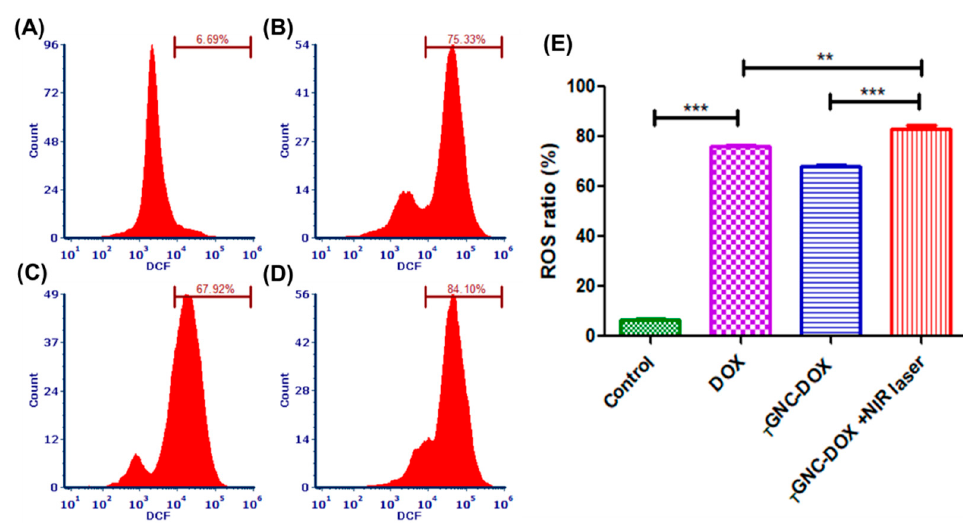
Figure 12. Intracellular ROS generation followed by treatment of: ( A ) control; ( B ) DOX; ( C ) T GNC-DOX only; ( D ) T GNC-DOX + NIR laser; and ( E ) bar graph of percentage ROS ratio of different treatment groups ( n = 3) (*** p < 0.001, ** p < 0.01).